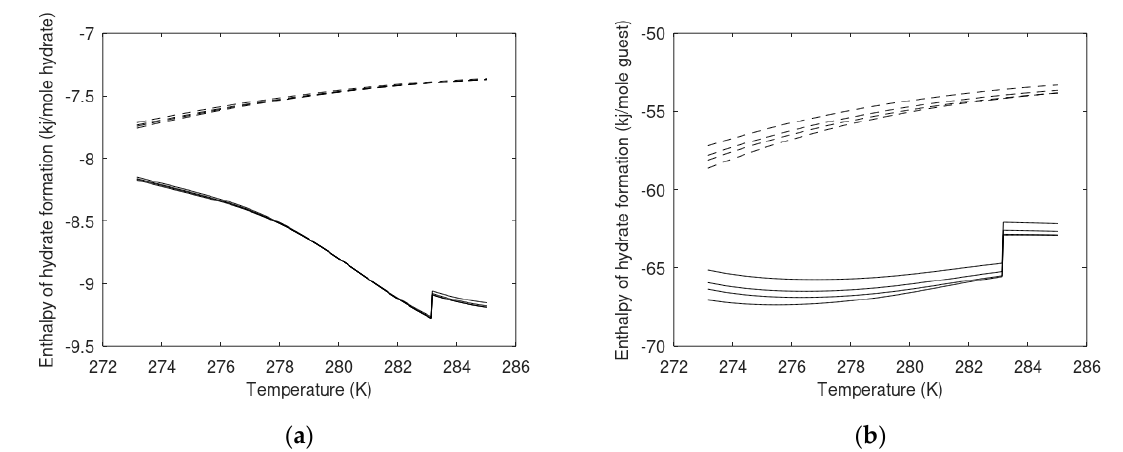
Figure 8. ( a ) Enthalpy of hydrate formation per mole hydrate and ( b ) enthalpy of hydrate formation per mole guest. Both figures are plotted as function of ethanol concentration in water. Dashed curves are for CH 4 hydrates formed from water with various mole-fractions ethanol in water. Solid curves are for hydrates formed from CO 2 with 20 mole% N 2 . Lowest curves are for no ethanol, then 0.015 mole-fraction ethanol in water, then 0.02 mole-fraction ethanol in water, and upper curves for 0.03 mole-fraction ethanol in water.